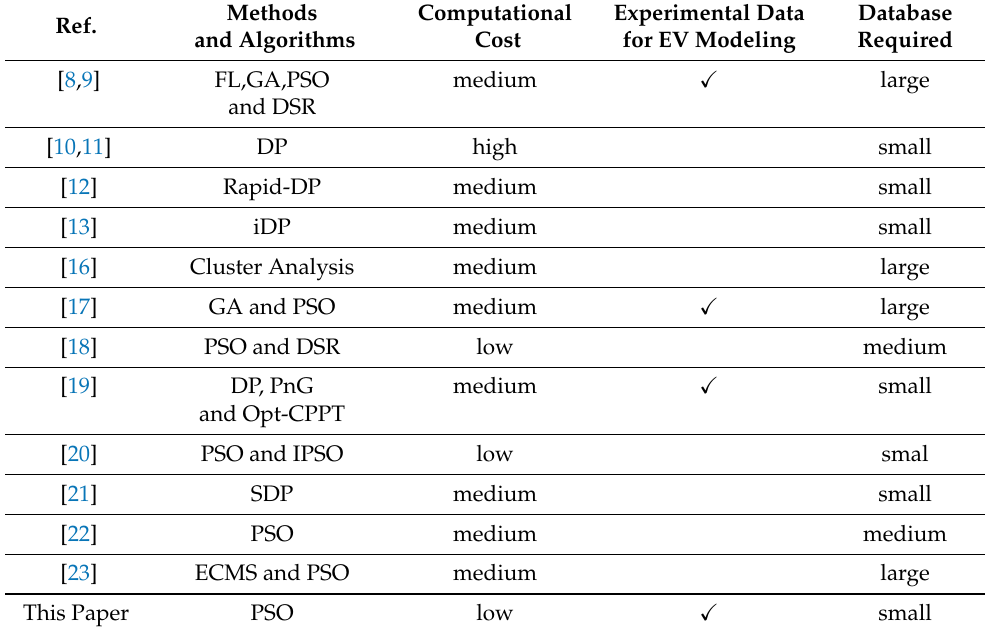
Table 1. Methods and algorithms, computational cost, EV performance experimental data, and re- quired database for training models used in the literature for tackling the problem of EV efficiency. Methods Computational Experimental Data Database Ref. and Algorithms for EV